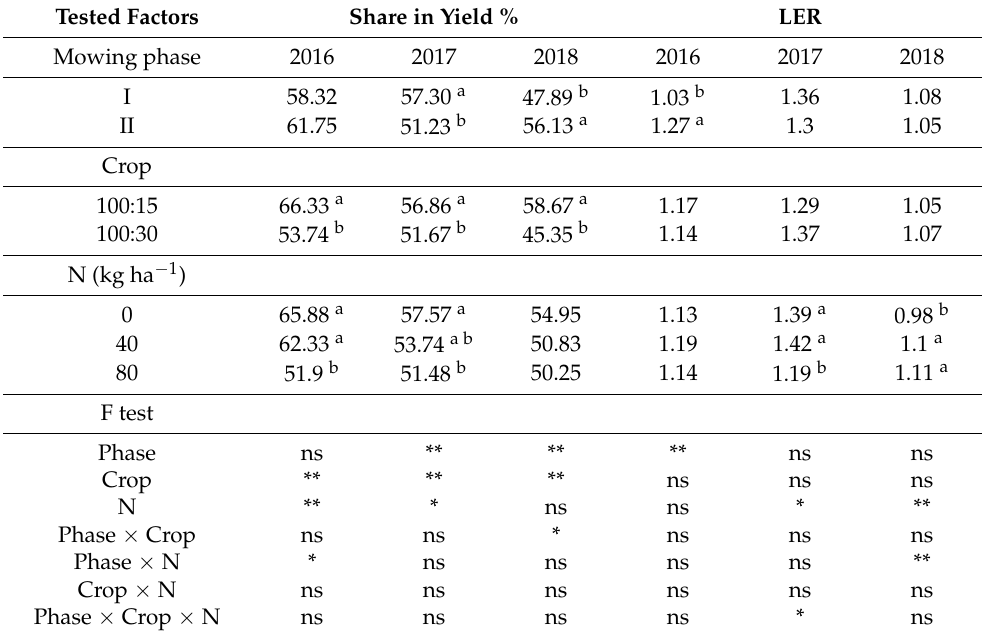
Table 5. Field peas share in the biomass yield and LER for field peas and oats mixtures under different levels of nitrogen fertilizer in two mowing